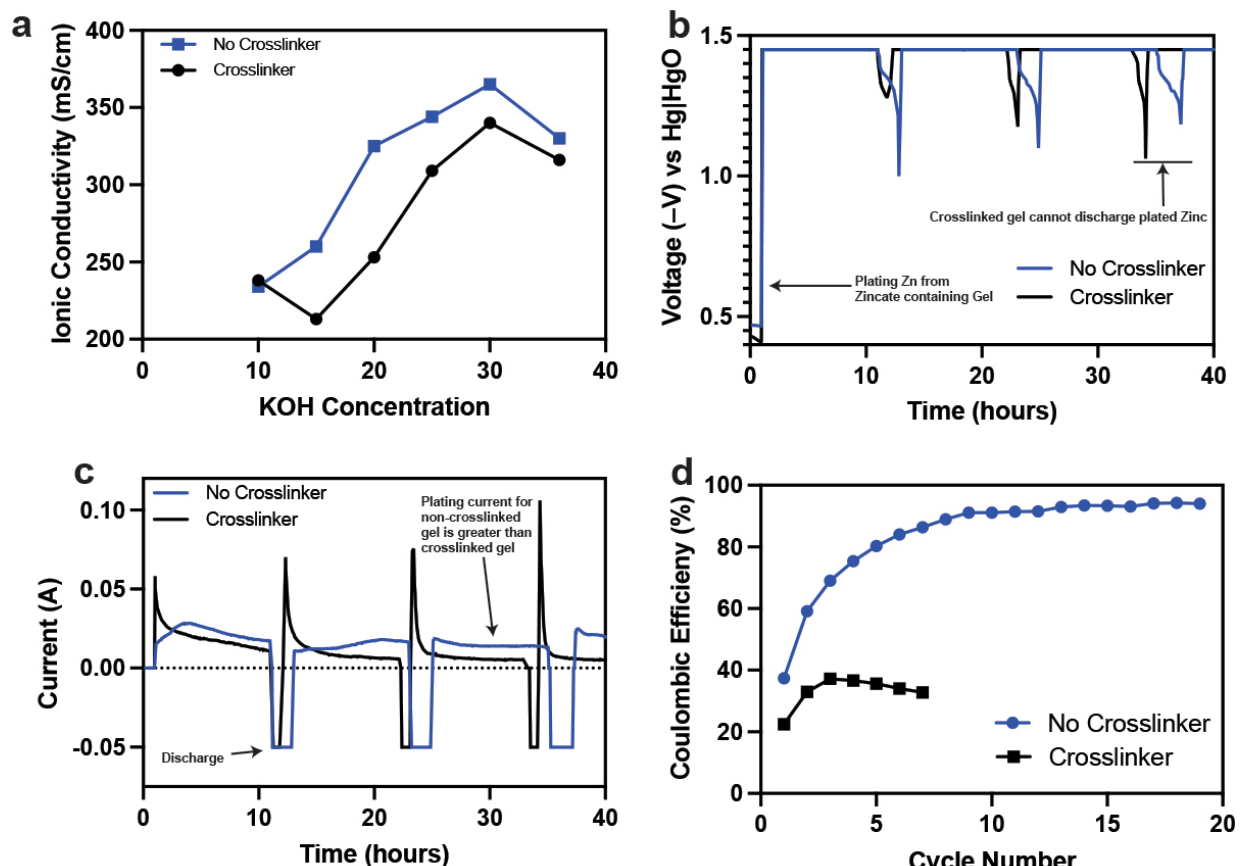
Figure 5. ( a ) Ionic conductivity comparison between non ‐ crosslinked and crosslinked gels. ( b ) Galvanostatic charge and discharge performance of Zn anodes in non ‐ crosslinked and crosslinked gels. ( c ) Current behavior on charge and discharge of electroplated Zn anodes in non ‐ crosslinked and crosslinked gels. ( d ) Coulombic efficiency comparison of anodes in non ‐ crosslinked and crosslinked gels.